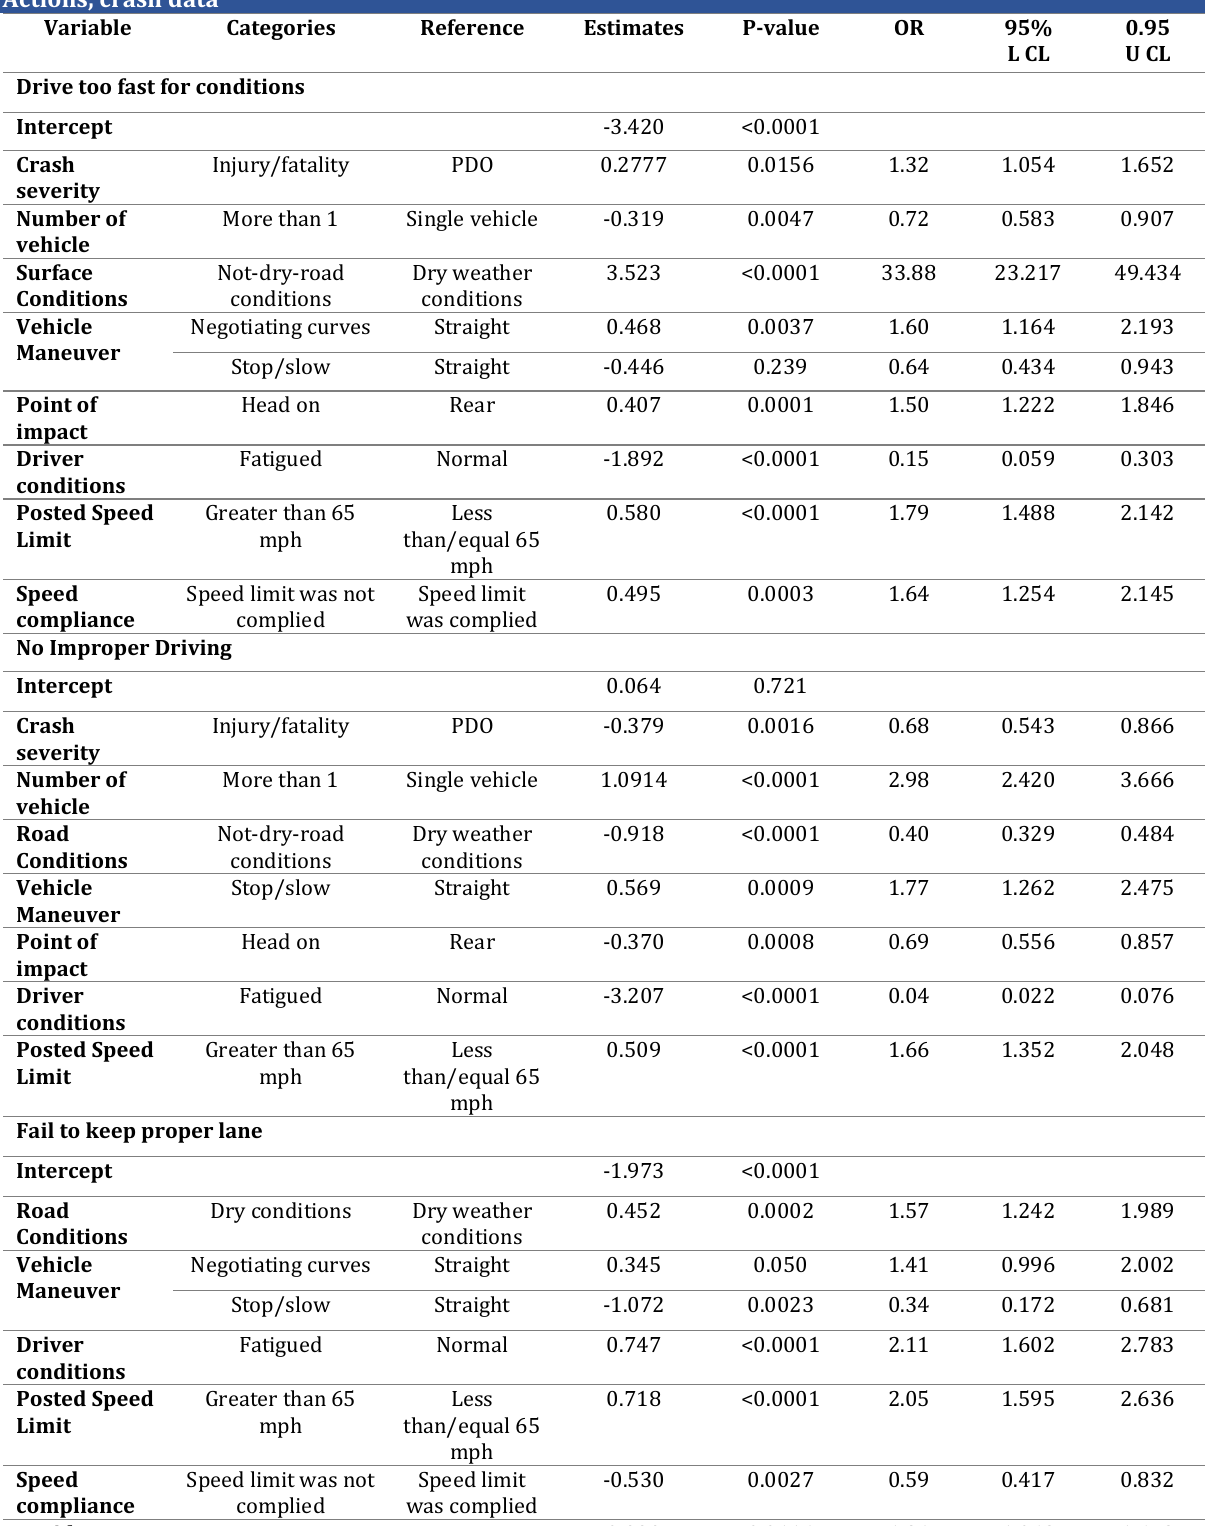
Table 2: Multinomial Logistic Regression, parameter Estimates and Odds ratios for different Driver Actions, crash